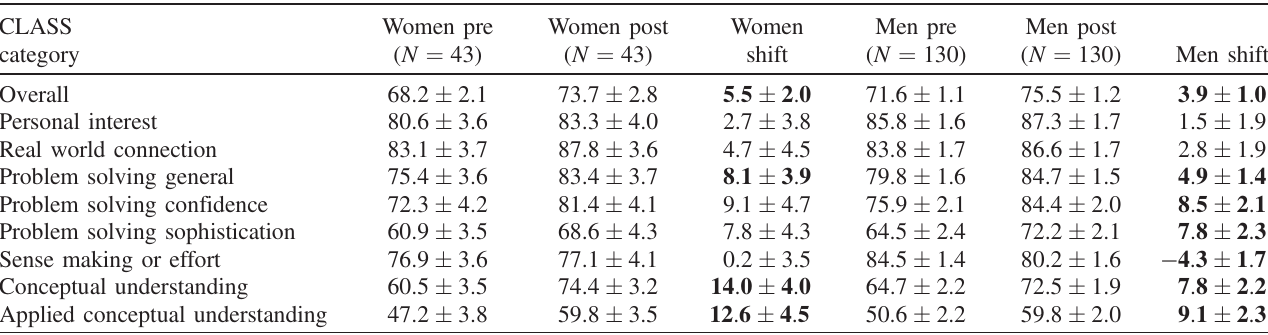
TABLE IV. Pre and post CLASS Scores (overall and category) for women and men. The shifts are measured by subtracting the pre- instruction score from the postinstruction score. Scores are reported (cid:2) the standard error of the mean. The bolded values represent a large shift, as defined as larger than 2 standard errors.